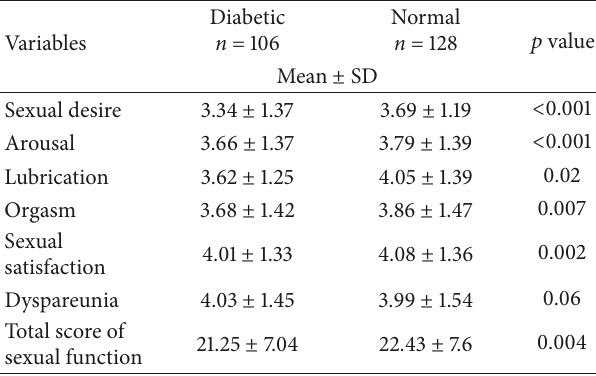
Table 3: The scores of different dimensions of sexual function in diabetic and healthy